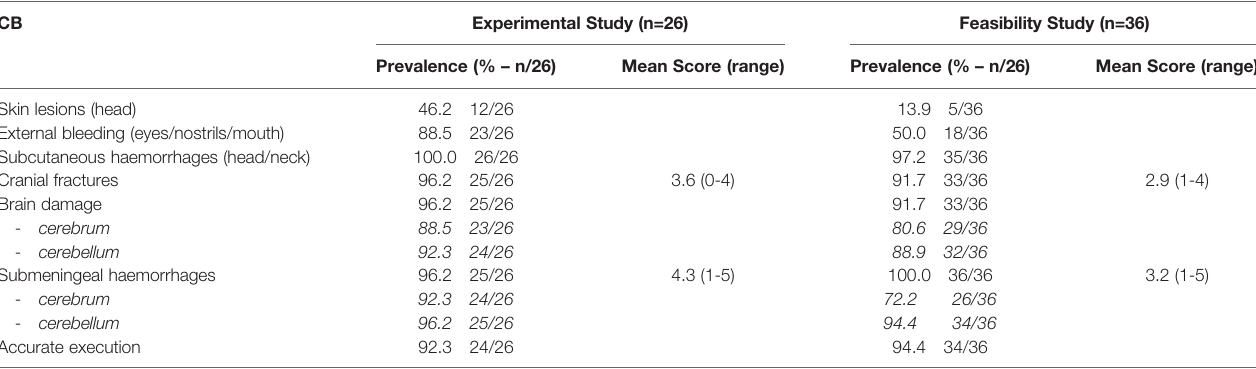
TABLE 5 | Summary of the post-mortem examination after captive bolt (CB) in Effectiveness and Animal Welfare Study (= Experimental study) and Feasibility study, with the prevalence (in % and ratio) of injuries speci fi c for CB, score (mean and range) of cranial fractures and submenigeal haemorrhages, and decision on the accuracy of execution of the killing method.